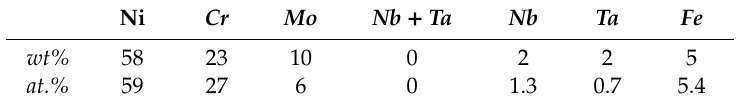
Table 1. Chemical composition of Alloy 625 for calculations in weight percent and atomic percent. Ni Cr Mo Nb + Ta Nb Ta Fe wt% 58 23 10 0 2 2 5 at.% 59 27 6 0 1.3 0.7